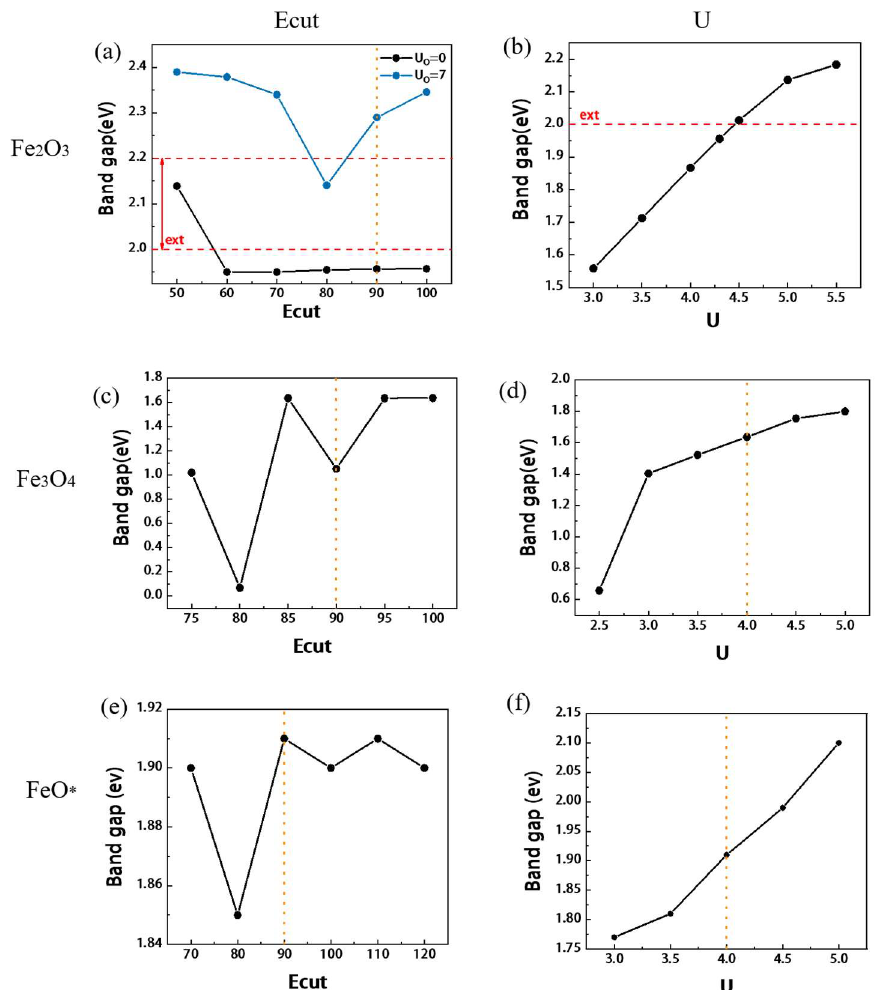
Figure 3. The results of the band gap for Fe 2 O 3 , Fe 3 O 4 , and FeO*, the horizontal direction is the same oxide parameter (( a , b ) for Fe 2 O 3 , ( c , d ) for Fe 3 O 4 , ( e , f ) for FeO*), and the vertical direction is the result of the same influence parameter. The orange dotted line is the position of the final value, and the red line is the experimental value.